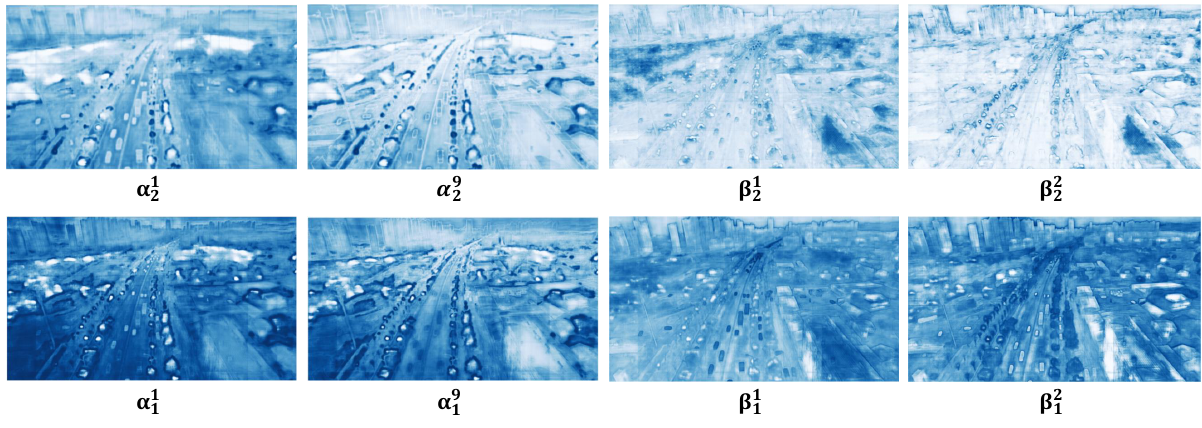
Figure 8. Attention analysis of different channels. Example attentions are of 1 × scale from Attn1 branch. The image on the top left shows the image adopted. The other 8 images are the attention maps from different channels. Channel indices are presented below the images. Brighter color means higher value. Best visualized with zoom in.